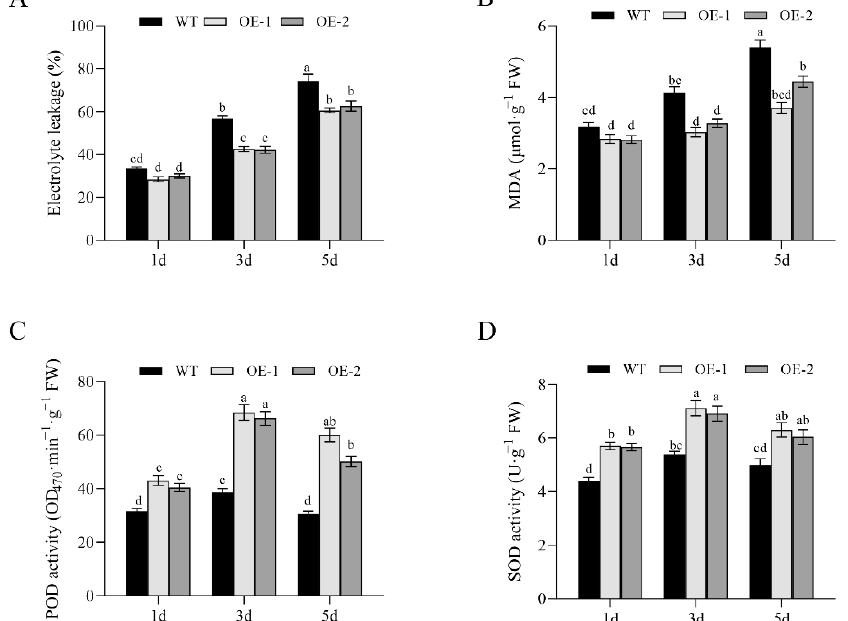
Figure 7. Results from determinations of change (%) of electrolyte leakage ( A ), malondialdehyde content ( B ), peroxidase activity ( C ), and superoxide dismutase activity ( D ) performed in samples collected throughout a five-day HS experiment in plants of two transgenic rice lines OE-1 and OE-2 overexpressing the OsNECD1 gene, as compared with untransformed plants (WT). Values are mean average ± SD of three replicates; values followed by the same letter were not significantly different at the 0.05 level, according to Duncan’s multiple range test.